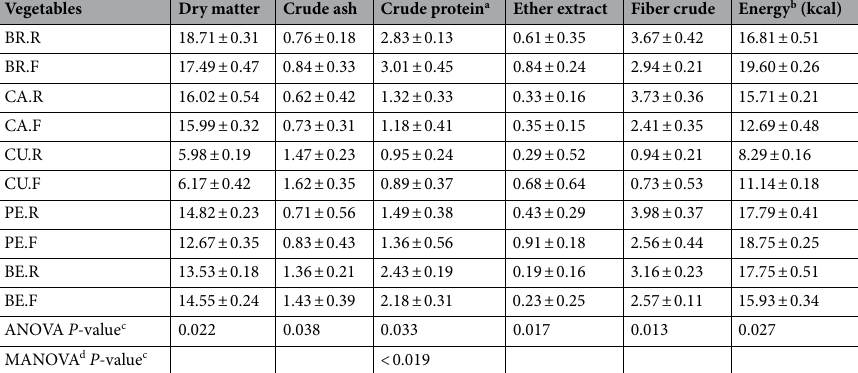
Table 4. Basic nutrients (g·100 g −1 fresh matter) and pH of raw and fermented vegetables. Results are the average ± standard deviation of four repetitions (n = 4) of each vegetable combination. a Calculated by Kjeldahl nitrogen N × 6.25. b In 100 g fresh matter. c P < 0.05 statistical differences. d Raw/fermented vegetables.